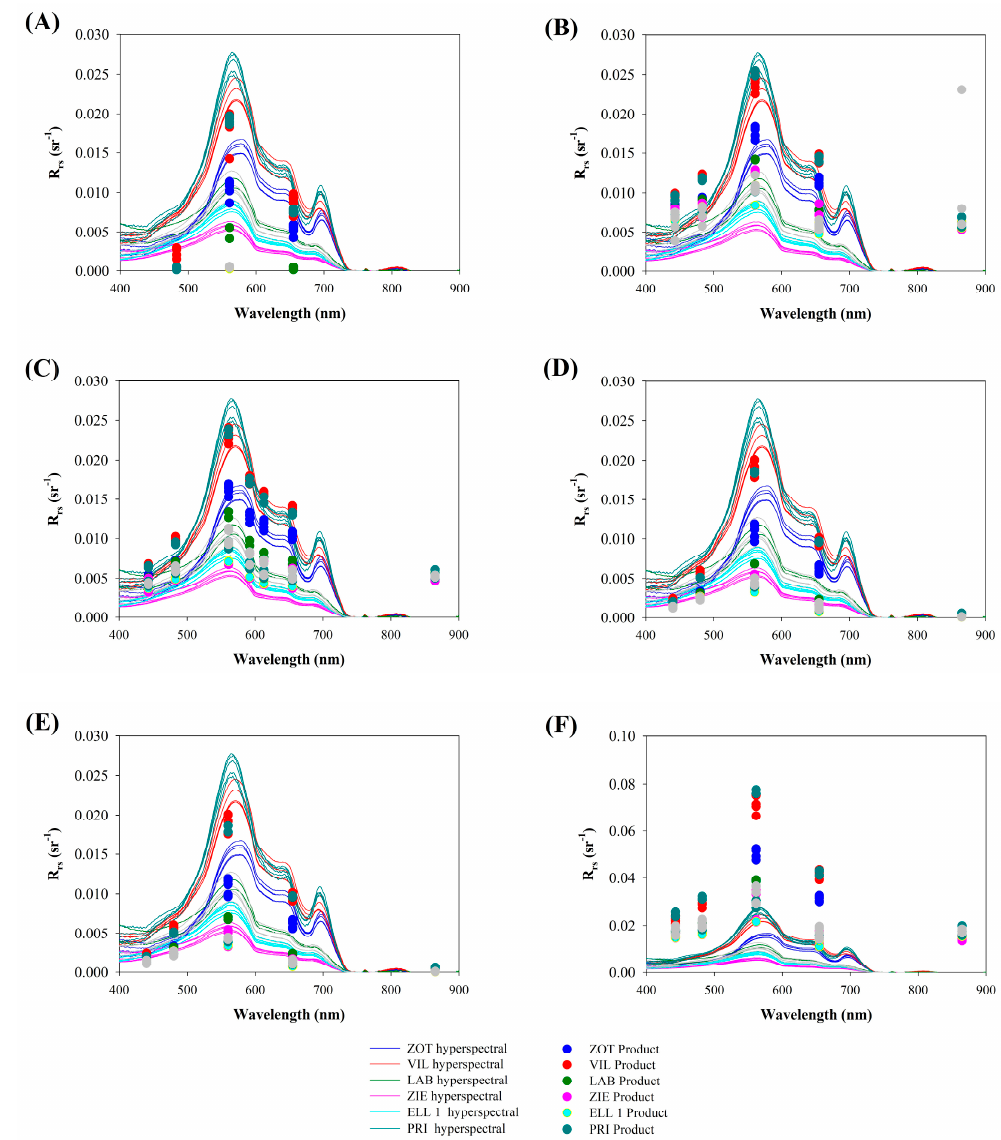
Figure 3. In situ hyperspectral R rs spectra (lines) and atmospheric corrected R rs per spectral band of Landsat 8 / OLI (points). ( A ) L8PAR; ( B ) L8SR; ( C ) ACOLITE; ( D ) C2RCC; ( E ) C2X; and ( F ) iCOR.